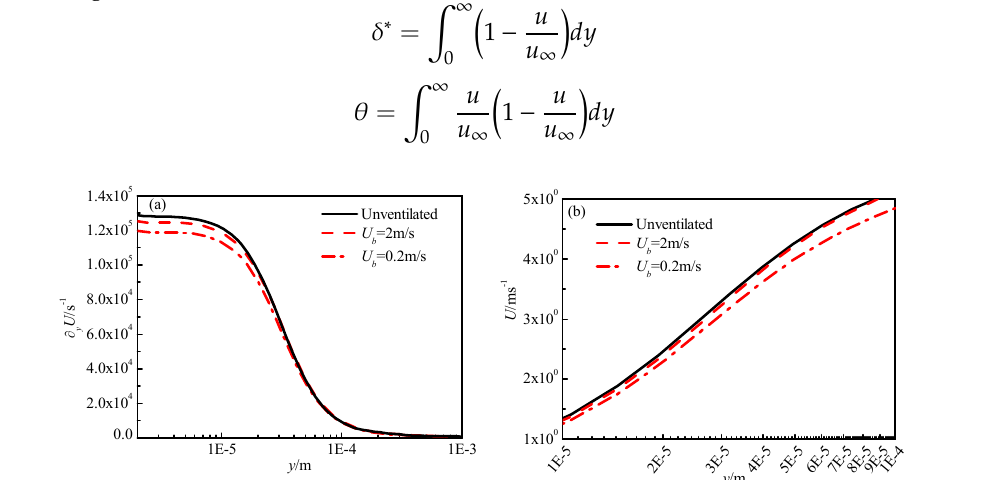
Figure 14. Profiles of mean velocity gradient and mean velocity: ( a ) mean velocity gradient and ( b ) mean velocity.